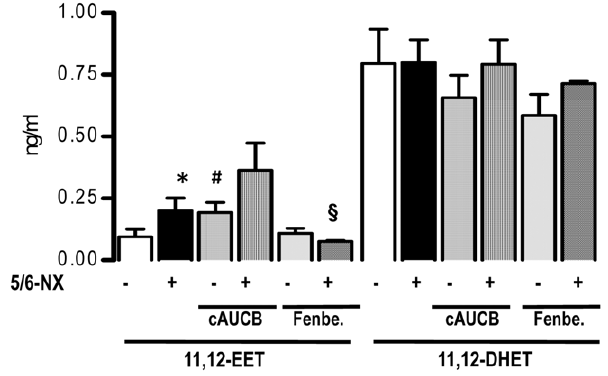
Figure 5. EET plasma level. 11,12-EET and 11,12-DHET plasma levels 8 weeks after initiation of treatment. Effects of placebo, sEH-inhibition by cAUCB, and CYP-inhibition by fenbendazole (Fenbe.) are shown on sham operated ( 2 ) and 5-6-Nx ( + ) animals. * p , 0,05 vs. sham, # p , 0,05 vs. placebo, 1 p , 0.05 vs. placebo and cAUCB (n=5–8/group).